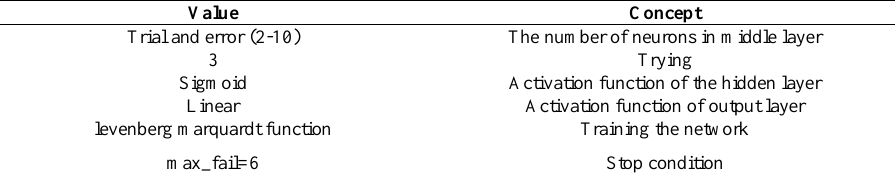
Table 1. Specification of (BP).